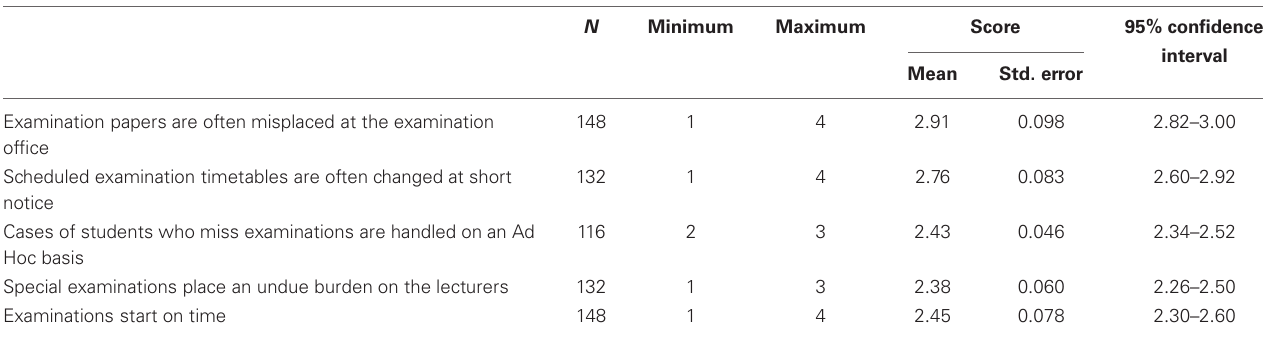
Table 7 | Examination administration at the University of